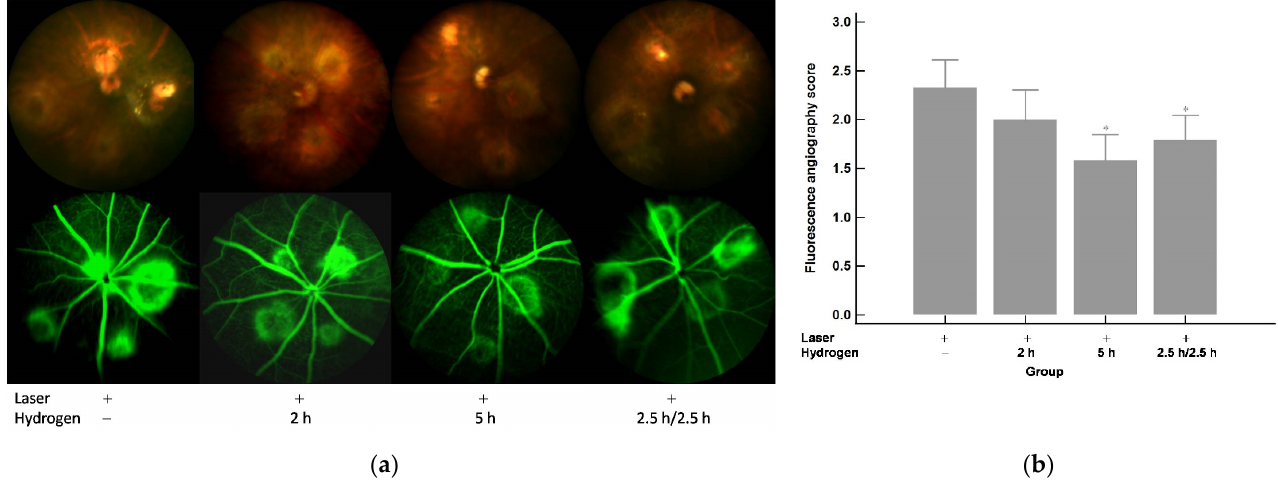
Figure 2. Day 15 (10 days after laser photocoagulation). ( a ) CFP and FA. ( b ) FA leakage scores. Significantly lower FA leakage scores were shown after the hydrogen inhalation compared to those without inhalation and the effect was inhalation period related. * p < 0.05 compared with the laser+ / hydrogen − group.